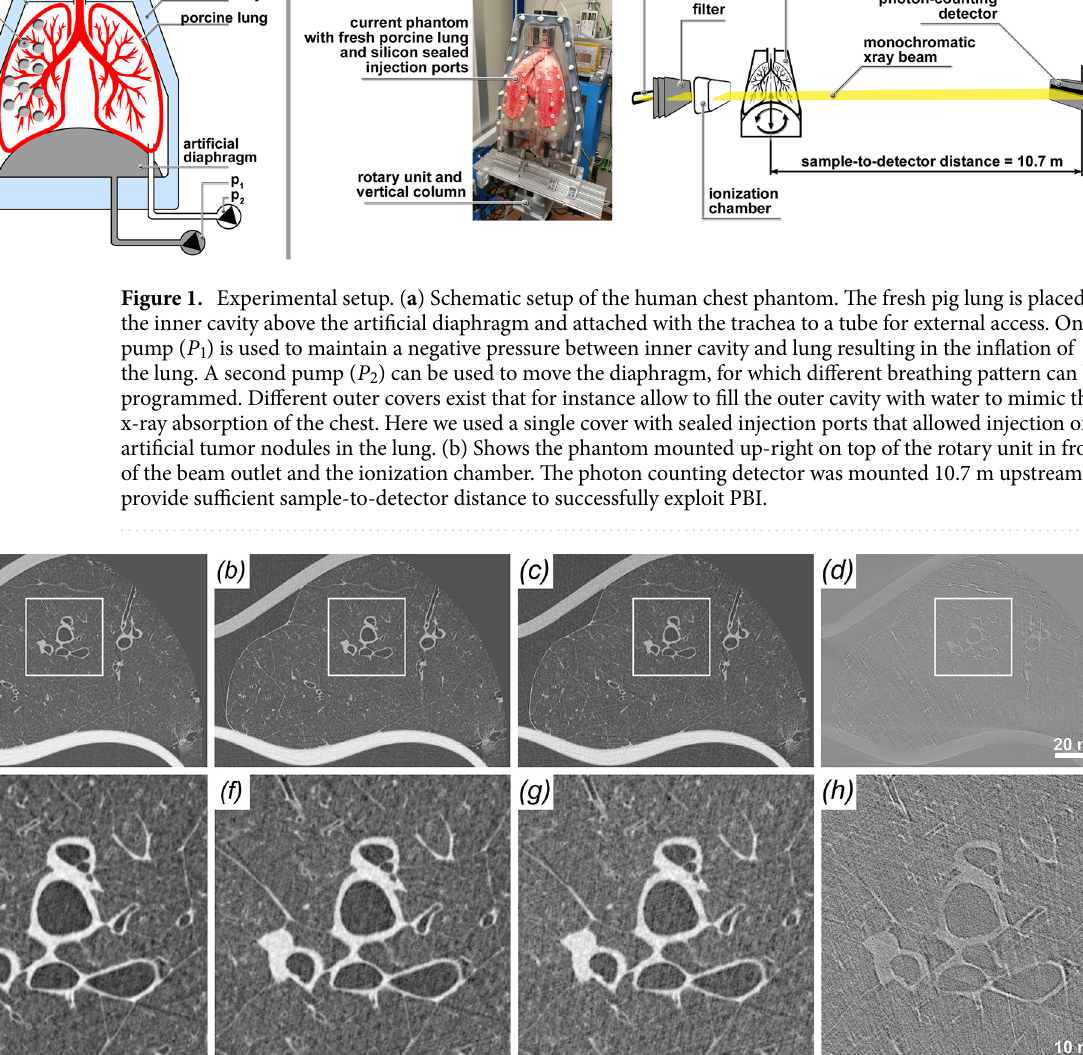
inflated lung mounted in the phantom using the front cover that includes silicon sealed injection ports as shown in Fig. 1b. Synchrotron inline phase contrast CT and single distance phase retrieval. For acquisition of the data the SYRMEP beamline of the “Elettra” synchrotron light source was used 39 . Due to the heavy weight of the phantom of approximately 45 kg a dedicated rotary unit was utilized. The whole setup is shown on Fig. 1. The customized XCounter Flite FX2 photon counting detector (Direct Conversion, Danderyd, Sweden) based on CdTe-CMOS with a pixel size of 100 µ m x 100 µ m was used and mounted in a 2 nd hutch downstream the beamline. With this setup we were able to realize a sample-to-detector distance (SDD) of 10.7 m. Data sets with 8100 angular projection images were acquired over 180 ◦ in 180 s. A monochromatic beam with an X-ray energy of 40 keV in combination with 20.15 mm of aluminium filters were used. Prior 3D reconstruction by using clas- sical filtered back projection (FBP), the TIE-Hom single distance phase retrieval algorithm was applied 13 , both implemented in the SYRMEP Tomo Project software (STP, Version 1.3.2) 40 . To demonstrate the gain in image